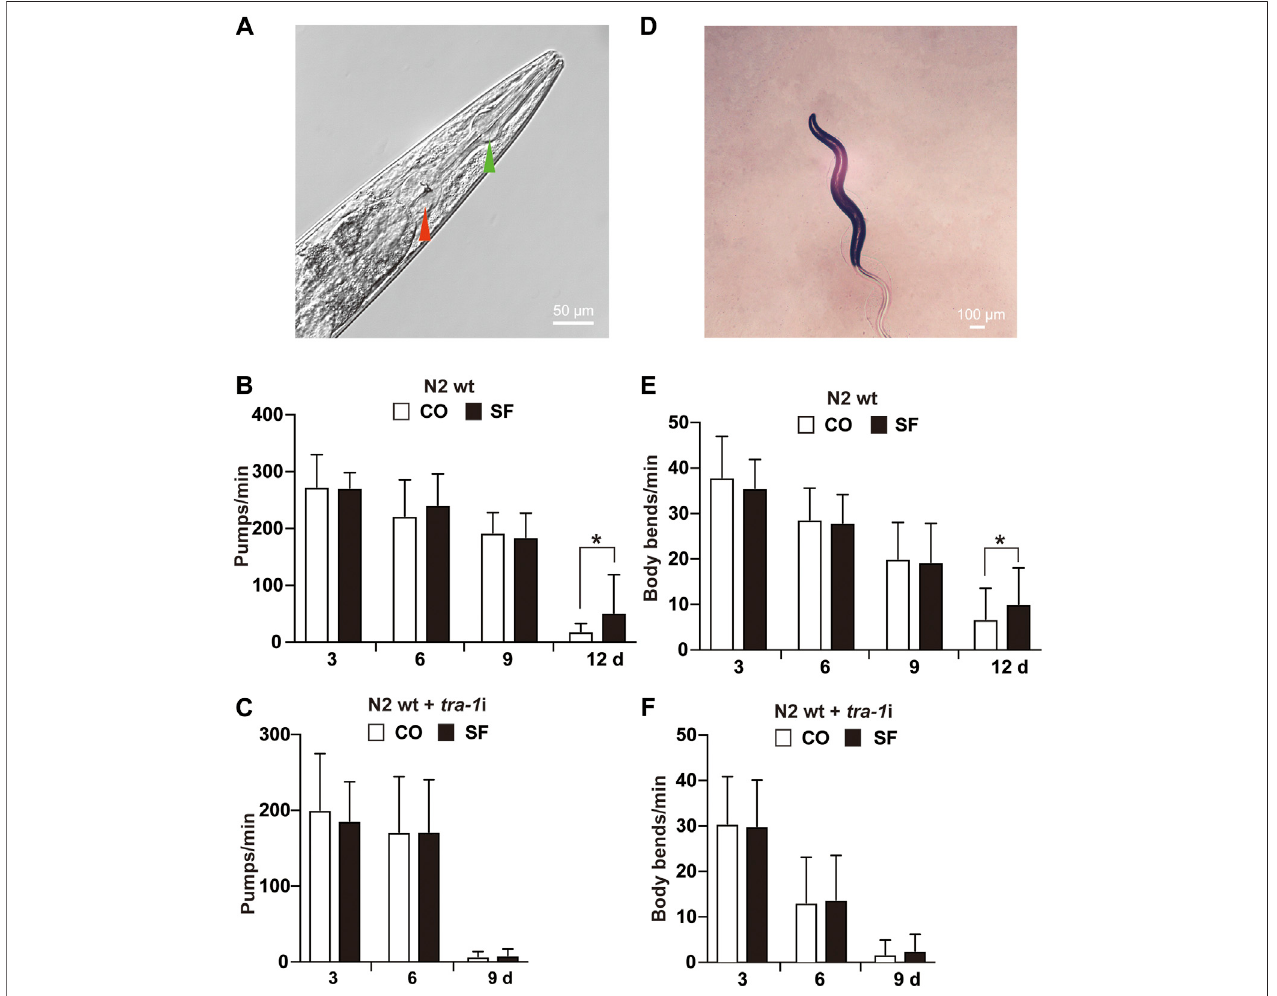
FIGURE3| Sulforaphaneincreasesthehealthspan via TRA-1. (A) The C.elegans anteriorpharynx(greenarrow)andtheterminalbulb(redarrow)areshown,which contract and relax synchronously during pharyngeal pumping. The scale bar indicates 50 µm. (B) Synchronized N2 wild-type C. elegans L4 larvae ( n (cid:1) 20/group) were exposed to 100 µM sulforaphane (SF) or not (CO) for 3, 6, 9, and 12 days. Afterward, pharyngeal pumping was detected under an inverted microscope. The pumping frequency per minute (Pumps/min) was calculated by evaluating the opening of the corpus, and the means, standard deviations and signi fi cance are shown in the diagram. (C) Synchronized N2 TJ356 C. elegans were fed tra-1 RNAi-transfected E. coli HT115 (DE3) bacteriain the presence of100 µM sulforaphane (SF) or not (CO). The pharyngeal pumping rate per minute (pumps/min) was detected at Days 3, 6, and 9. For each treatment, 20 worms were examined. (D) Image of a C. elegans nematodetovisualizebodybends.Achangeintheposteriorbulbdirectionorregularswingingoftheheadwasconsideredabodybend.Thescalebarindicates100 µm. (E) SynchronizedN2wild-typeL4larvae( n (cid:1) 50/group)receivedaregulardiet(CO)orwerefed100 µMsulforaphaneoncultureplates(SF).Next,3,6,9,or12dayslater, the mobility of C. elegans was detected by counting the body bends per minute (body bends/min). (F) Synchronized N2 wild-type C. elegans were fed tra-1 RNAi- transfected E. coli HT115 (DE3) bacteria in the presence of 100 µM sulforaphane (SF) or not (CO), and the body bends per minute were evaluated at the time points indicated. The data are expressed as means ± SEM. * p < 0.05, ** p < 0.01.